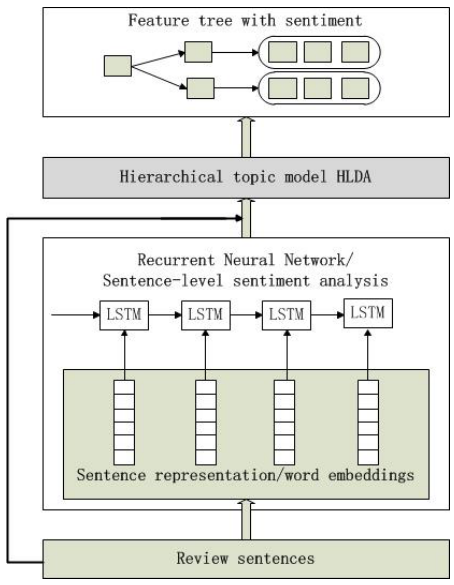
Figure 1. The joint model framework